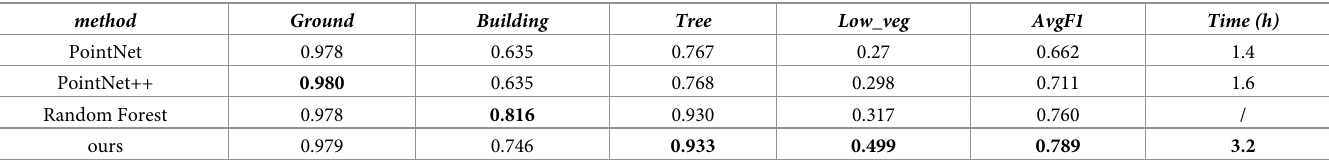
Boldface text means the highest value in the